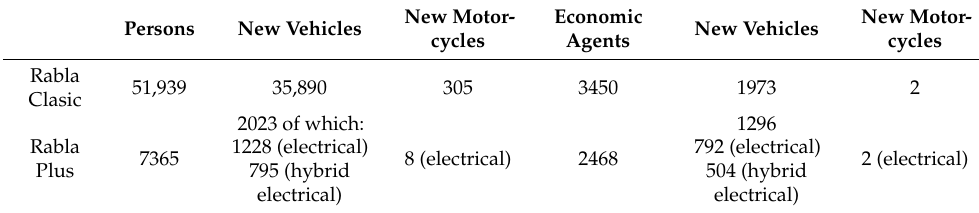
Table made by authors with data source from AFM